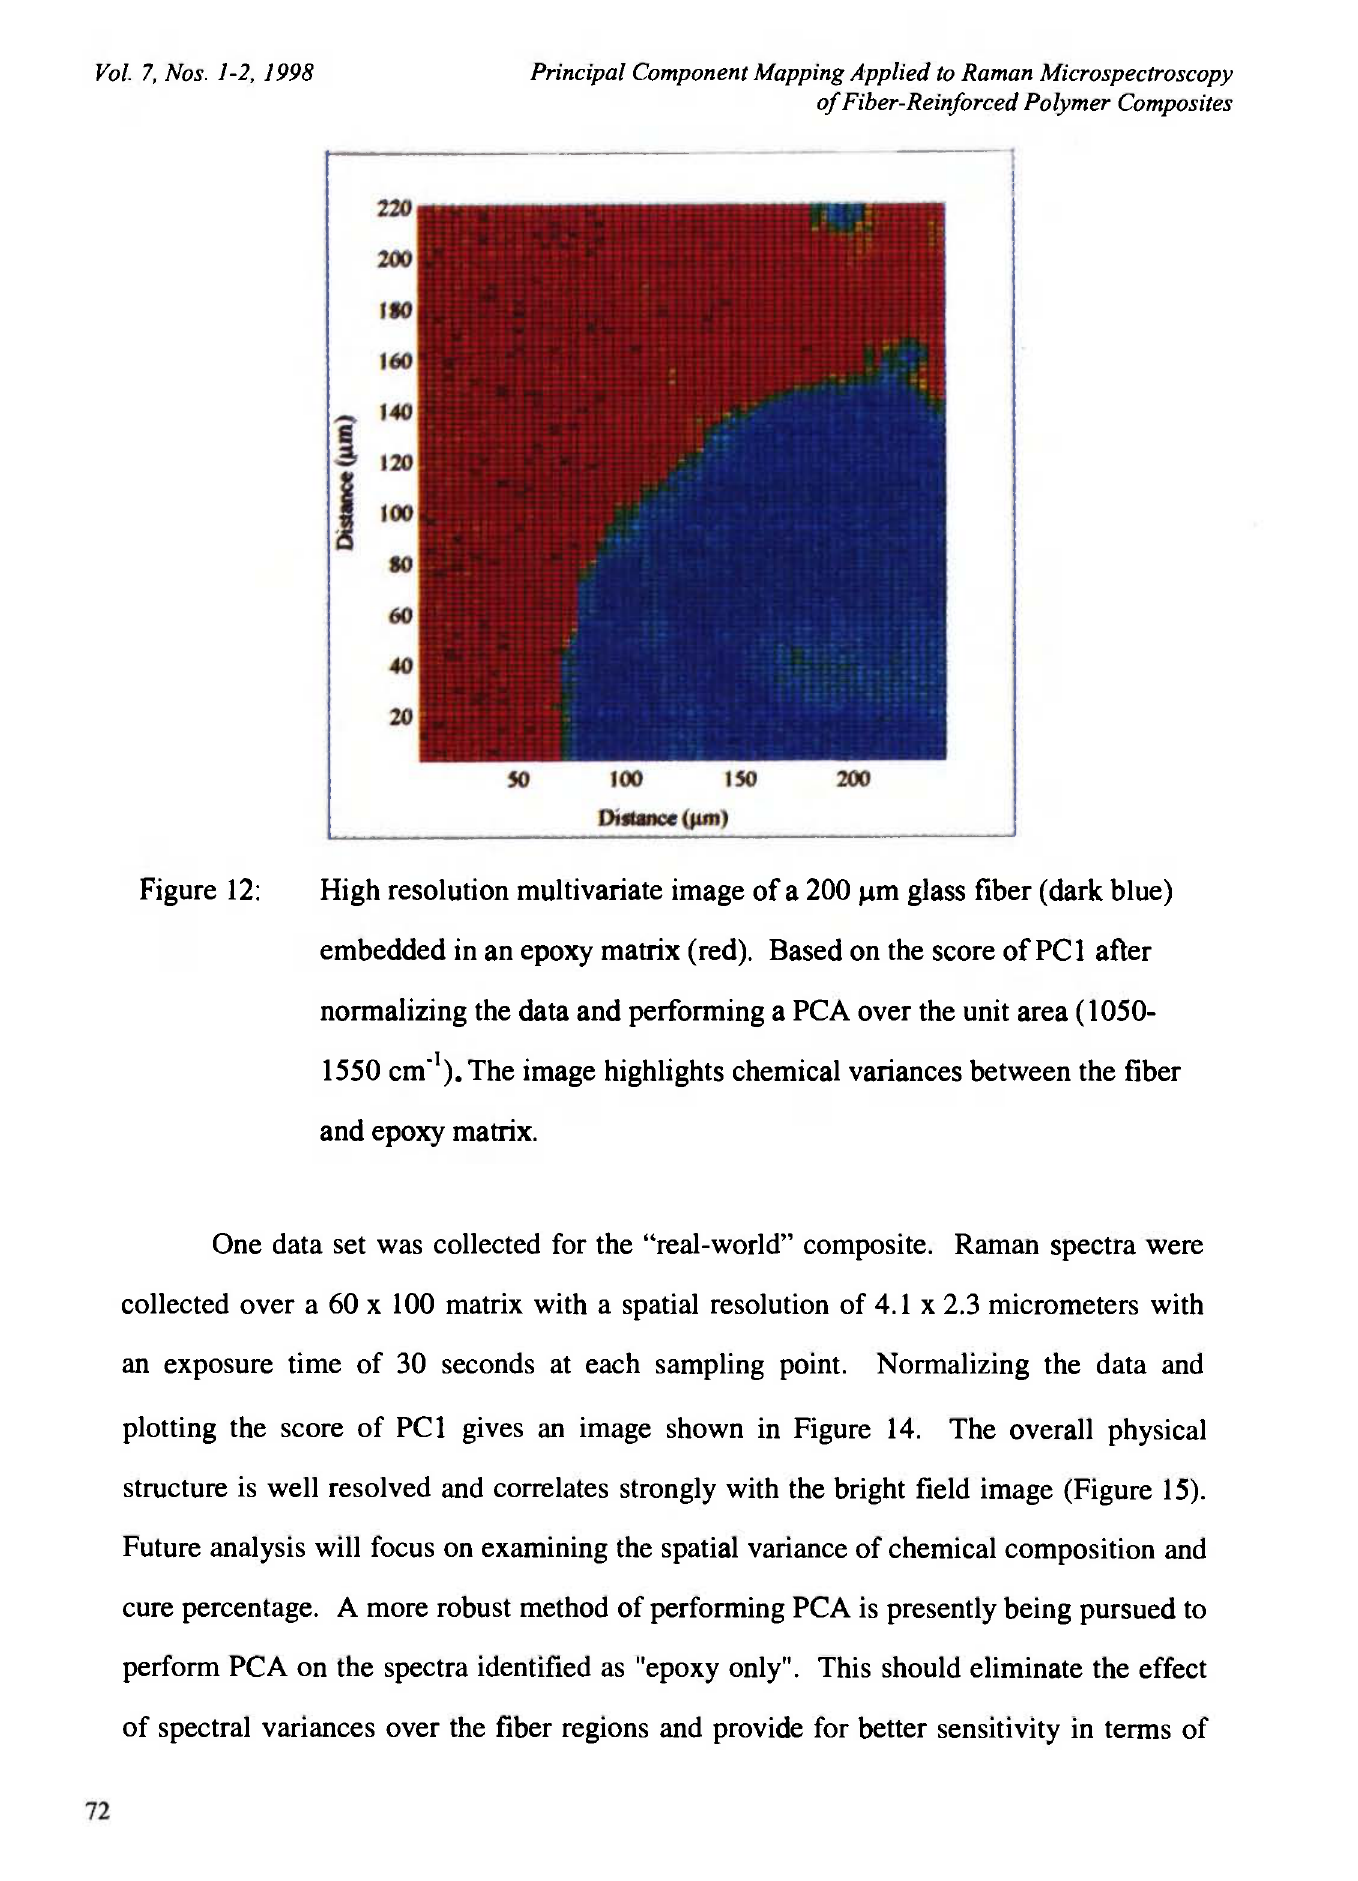
Figure 12: High resolution multivariate image of a 200 μπι glass fiber (dark blue) embedded in an epoxy matrix (red). Based on the score of PCI after normalizing the data and performing a PCA over the unit area (1050- 1550 cm' 1 ). The image highlights chemical variances between the fiber and epoxy